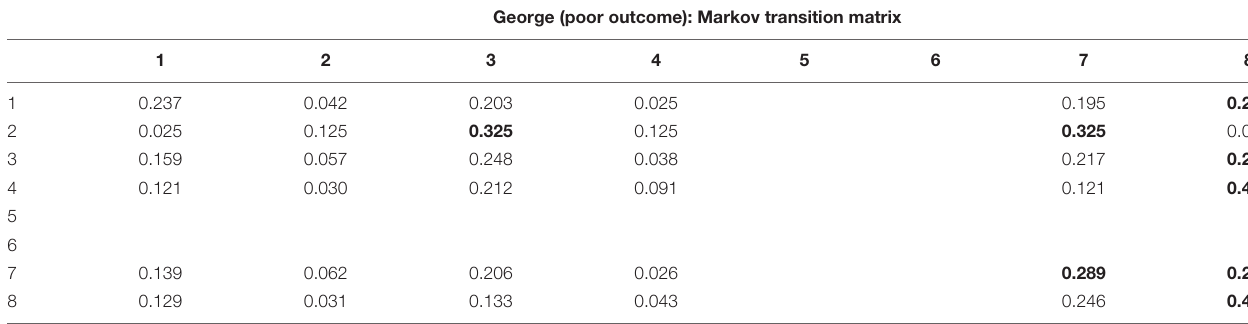
TABLE 2 | The number of clusters or states of the system is indicated in the rows and columns. George (poor outcome): Markov transition